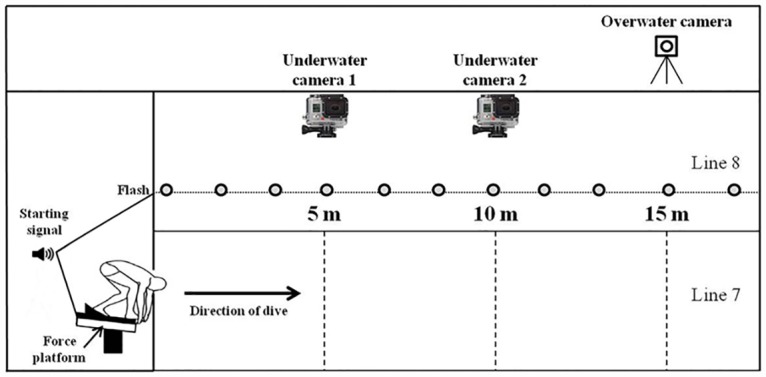
Graphical representation of the measurement equipment used to analyze swimming start performance.Note that another starting flash (not depicted) was positioned at the other poolside perpendicular to the overwater camera.